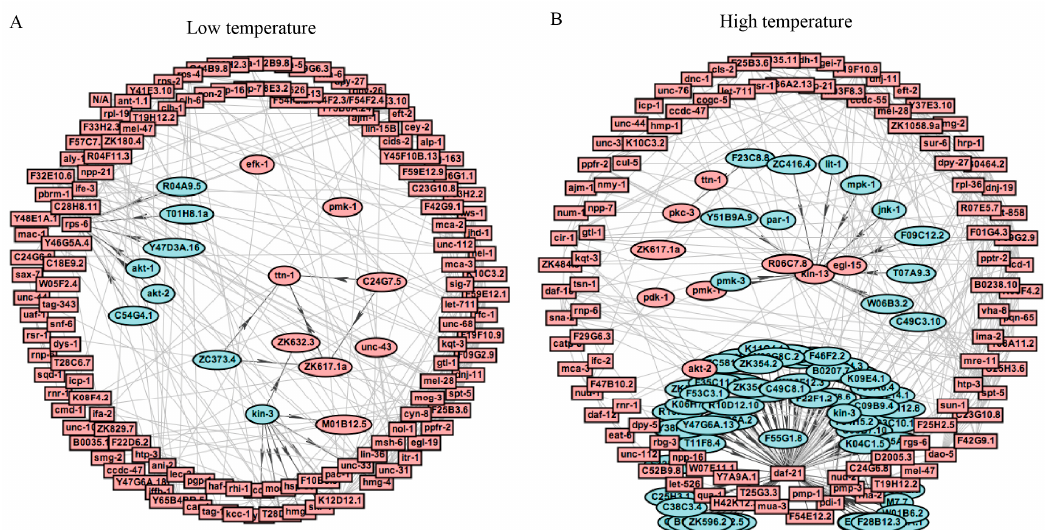
Figure 6. Interaction analysis of kinase substrate relationships of DRPs. (A) Kinase substrate interaction analysis of these proteins exposed to 15 °C. (B) Kinase substrate interaction analysis of these proteins exposed to 25 °C.